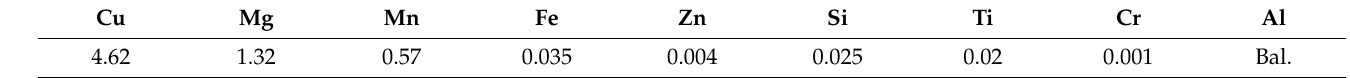
Table 1. Chemical composition of 2524 aluminum alloy (mass fraction: wt%).